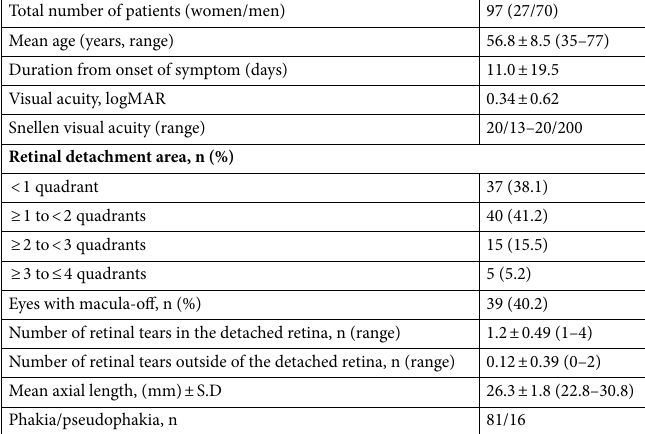
Total number of patients (women/men) 97 (27/70) Mean age (years,